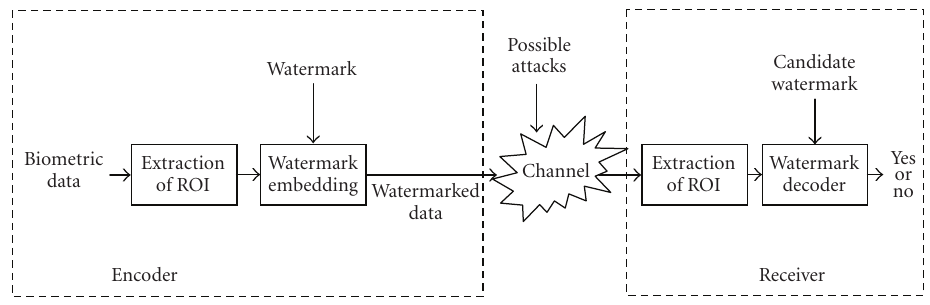
Figure 2: Proposed watermarking scheme for biometric